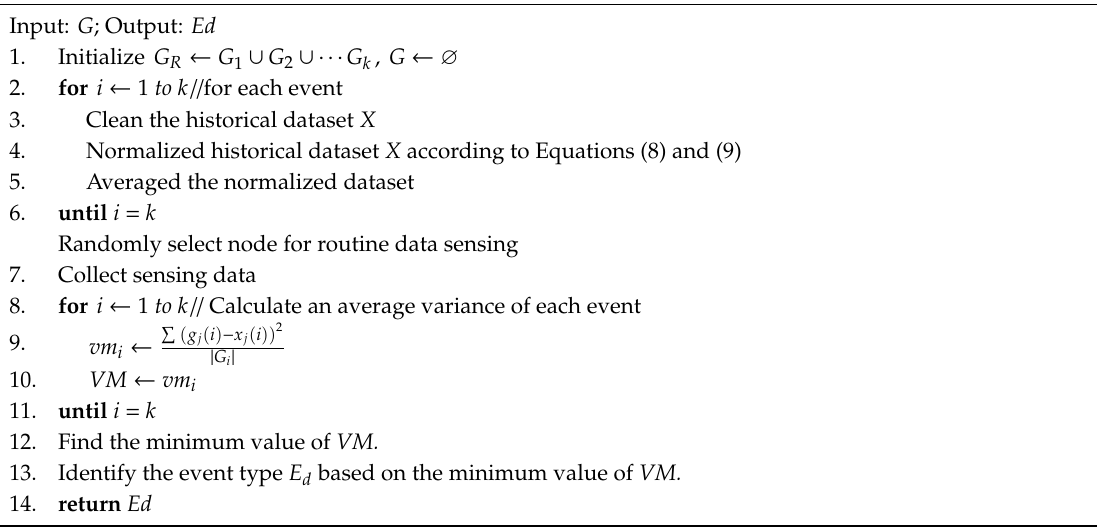
Algorithm 2 Event identification method based on the minimum